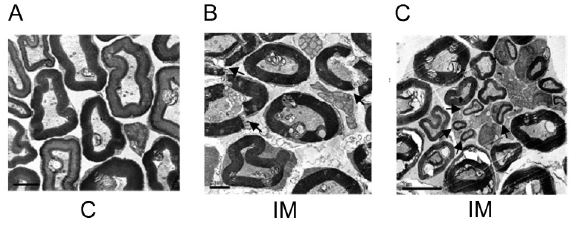
Figure 2. Electron micrographs of sciatic nerves (SN) from control ( A ) and immobilized rats ( B and C ). Note the immobiliza- tion-induced degeneration of myelin sheath of large diameter axons (arrows) of immobilized animals ( B ). Clusters of thin fibers (arrows) can also be seen in the SN of immobilized animals ( C ). Magnification bars: 2, 2, and 5 m m for A , B , and C , respectively. C: control; IM: immobilized.